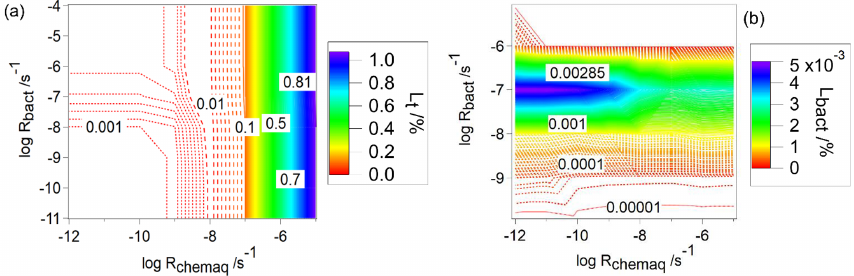
Figure 8. Predicted loss of CCN-derived species as a function of R chemaq and R bact , (a) total loss ( L t ), (b) loss by biodegradation ( L bact ).